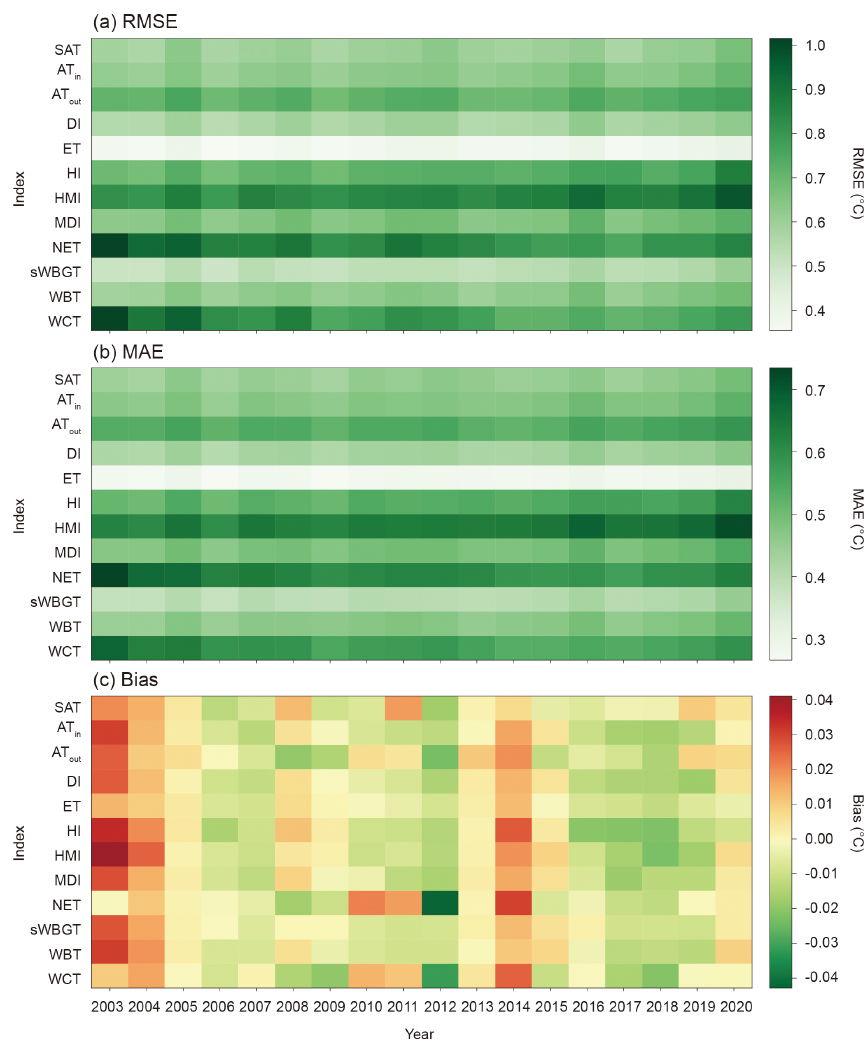
Figure 8. Annual prediction accuracies of the 12 human thermal indices over the mainland of China during 2003–2020: (a) RMSE, (b) MAE, and (c)